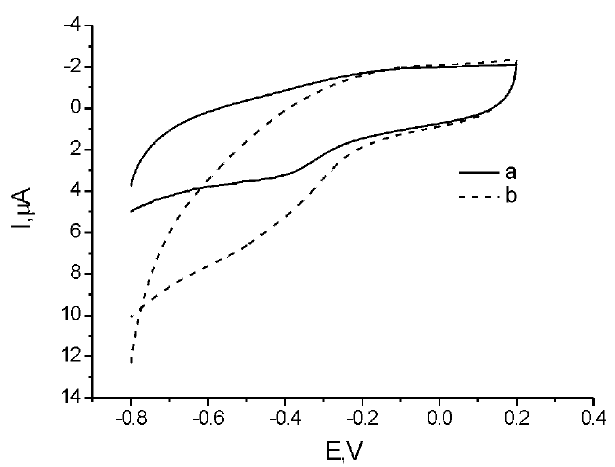
Figure 3. Cyclic voltammetric detection at ssDNA-SWCNTelectrode before (a) and after (b) adding of